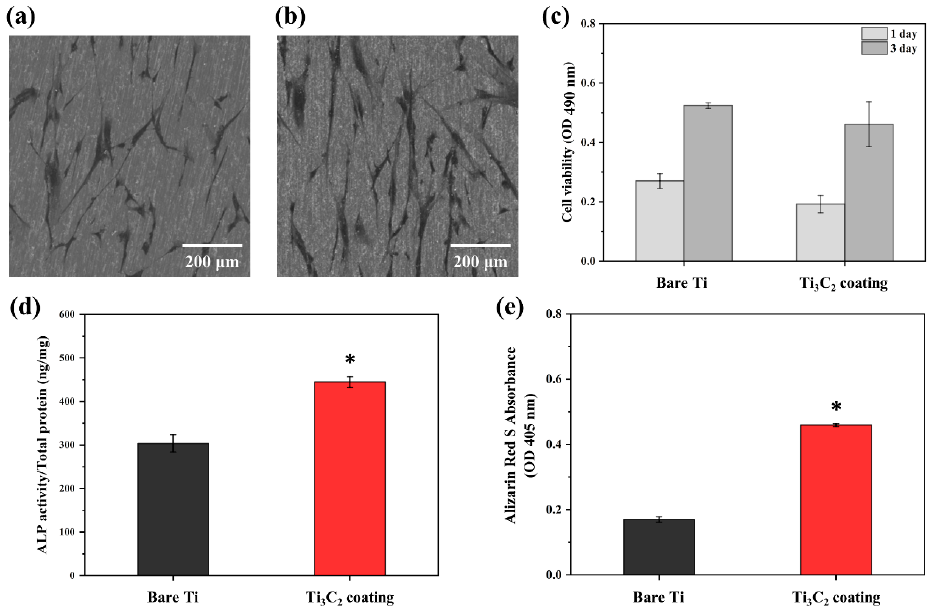
Figure 3. FE-SEM images of hMSCs cultured on ( a ) bare and ( b ) Ti 3 C 2 -coated Ti. Levels of ( c ) cell viability measured using the MTS method and osteogenic differentiation assessed by means of ( d ) ALP activity and ( e ) ARS staining methods. (*: p <